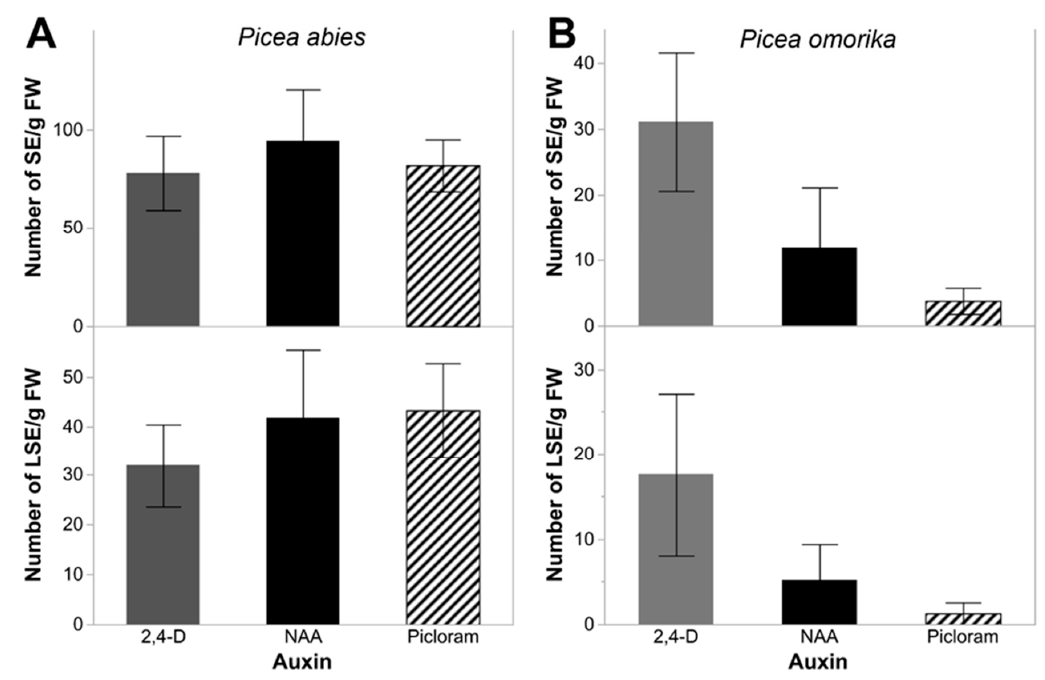
Figure 4. The mean number of somatic embryos and the mean number of cotyledonary stage embryos per gram of fresh weight of the tissue produced by ET lines of P. abies ( A ) and P. omorika ( B ) in relationship to the PGR type used during the induction of the ET lines. Data are means with standard errors from 5 replicates from each tested line.